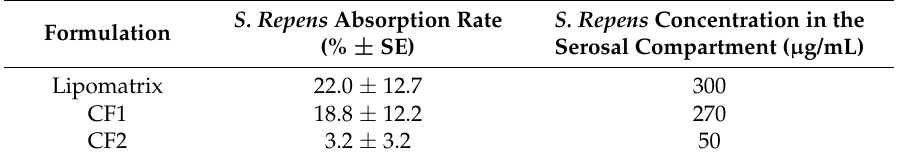
Table 8. Absorption rate expressed as a percentage of SRO absorption ± standard error (SE) and concentration ( µ g/mL) at the basolateral compartment